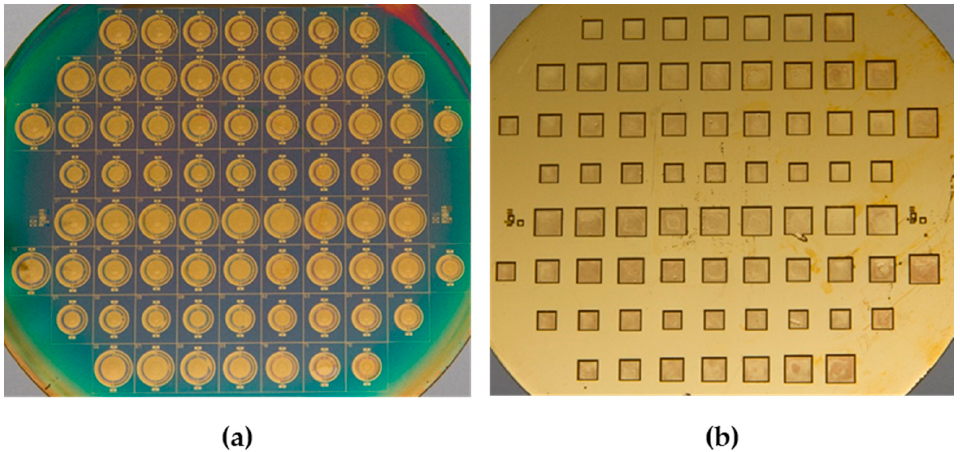
Figure 6. ( a ) Top-view and ( b ) bottom-view optical micrographs of the implemented FPW chip.